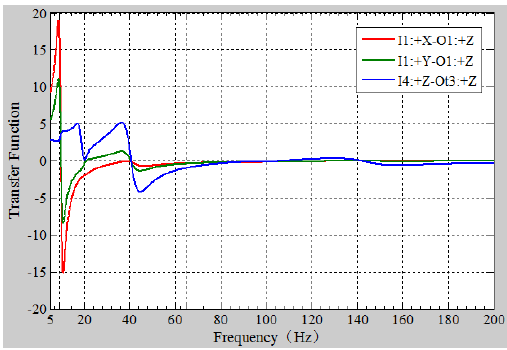
Figure 8. Analysis diagram of Z-direction path contribution of output point O3.